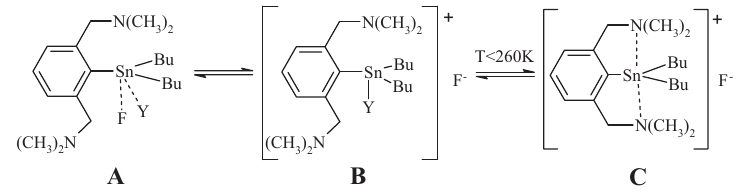
Figure 8 Structural behavior of L NCN ( n -Bu)